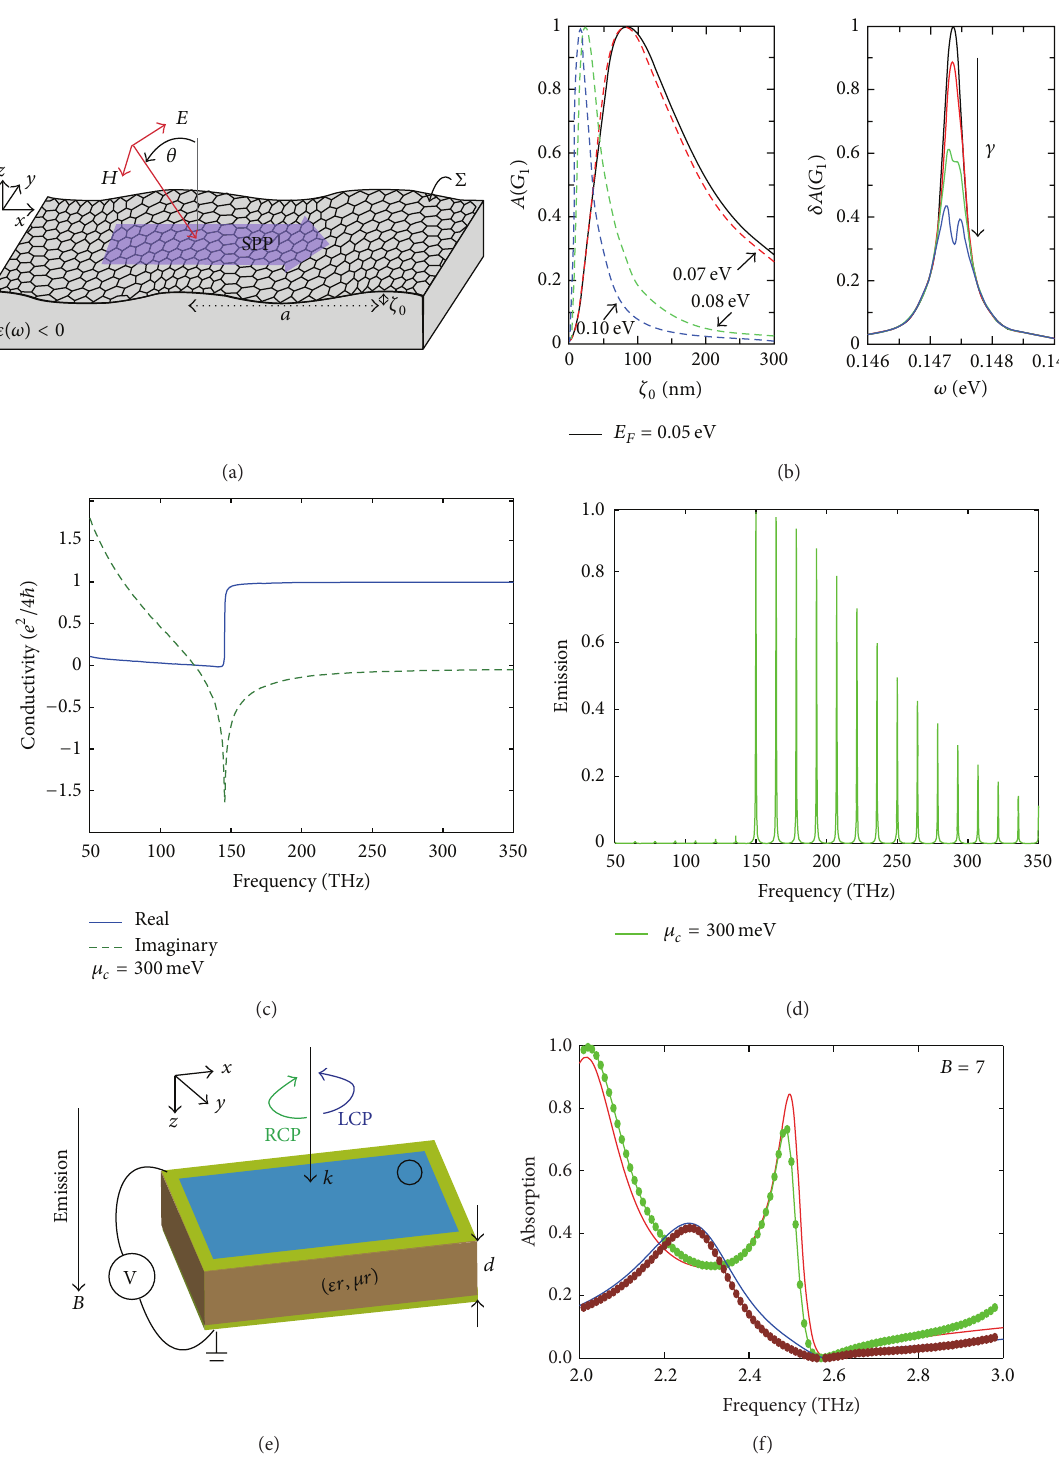
Figure 50: (a) Schematic picture showing transverse magnetic light impinging on graphene placed on a periodically structured conducting substrate. The light is converted into surface plasmonic waves and subsequently absorbed in graphene. (b) Dependence of the absorption at resonance on the corrugation height (left panel) for different graphene Fermi energies, 𝐸 𝐹 , and relative absorption for a nonzero metamaterial relaxation’s rate. (c) Optical conductivity of graphene under electric bias. (d) Thermal emission property of the grapheme layer obtained from Kirchhoff’s law. (e) Schematic of the graphene absorber under both electric bias and magnetic bias. (f) Absorption of the dual-biased absorber. Figures are reproduced from [249, 251,